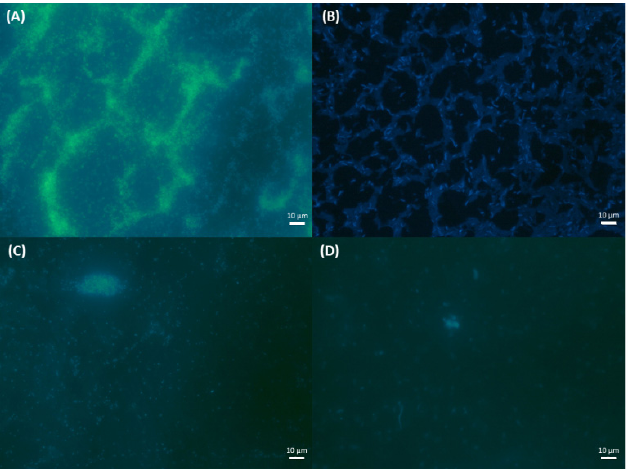
Figure 9. Adhesion of bacterial cells to glass surface after 6-day incubation and DAPI staining. ( A ) S. aureus and DMSO; ( B ) E.coli and DMSO; ( C ) S. aureus and CuHABH, and ( D ) E. coli and CuHABH. Bars represent 10 μ m.